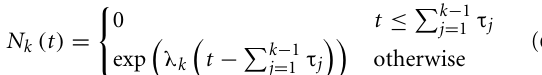
FIGURE 2 | Proliferating healthy cells in the bone marrow mutate at random times, possibly influenced by super-pharmacological doses of GCSF. As long as the cell population size is kept in check, genetic drift, and selection remove many of the mutants, whereas some mutants